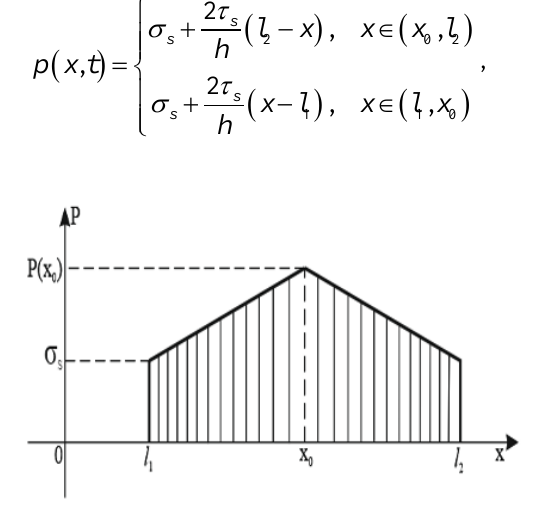
Fig.1. Contact pressure distribution in the problem of plastic layer free spreading.